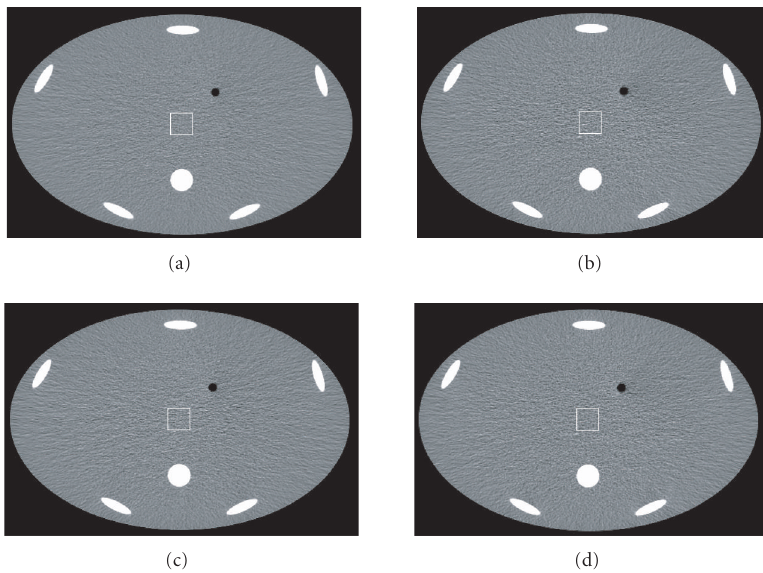
Figure 3: Tomographic images of the helical body phantom reconstructed by (a) the original algorithm using full-scan data at helical pitch 33 / 64 : 1; (b) the extended algorithm using overscan data at helical pitch 33 / 64 : 1; (c) the original algorithm using full-scan data at helical pitch 63 / 64 : 1; and (d) the extended algorithm using overscan data at helical pitch 63 / 64 : 1 (w/l = 200/0 HU).